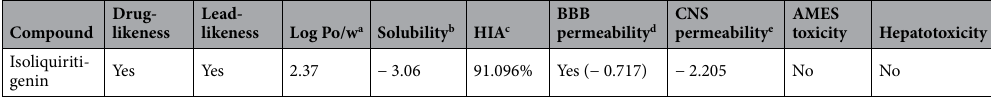
Table 6. Prediction of the pharmacokinetic parameters and toxicity of isoliquiritigenin. a Octanol-water partition coefficient. b LogS scale: Insoluble < − 10 < Poorly < − 6 < Moderately < − 4 < Soluble < − 2 < Very < 0 < Highly. c Human intestinal absorption: If < 30%, poorly absorbed. d Log BB > 0.3 considered to readily